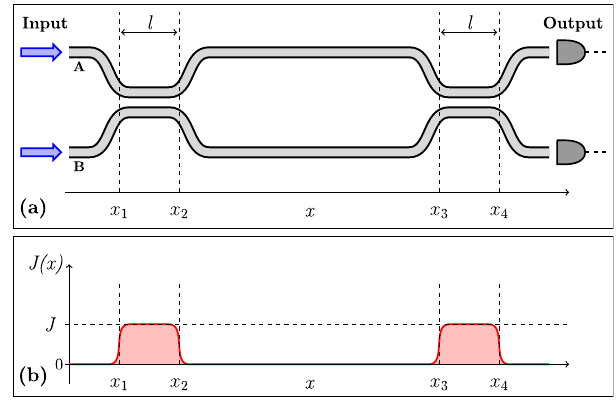
circuit made of two identical hopping regions of length l separated by a free propagation region. b Sketch of the spatial dependence of the hopping parameter J ( x ) along the device in a . As in the case of the elementary QPIC in Fig. 3, we consider J ( x ) = J in the two interaction regions and zero elsewhere.